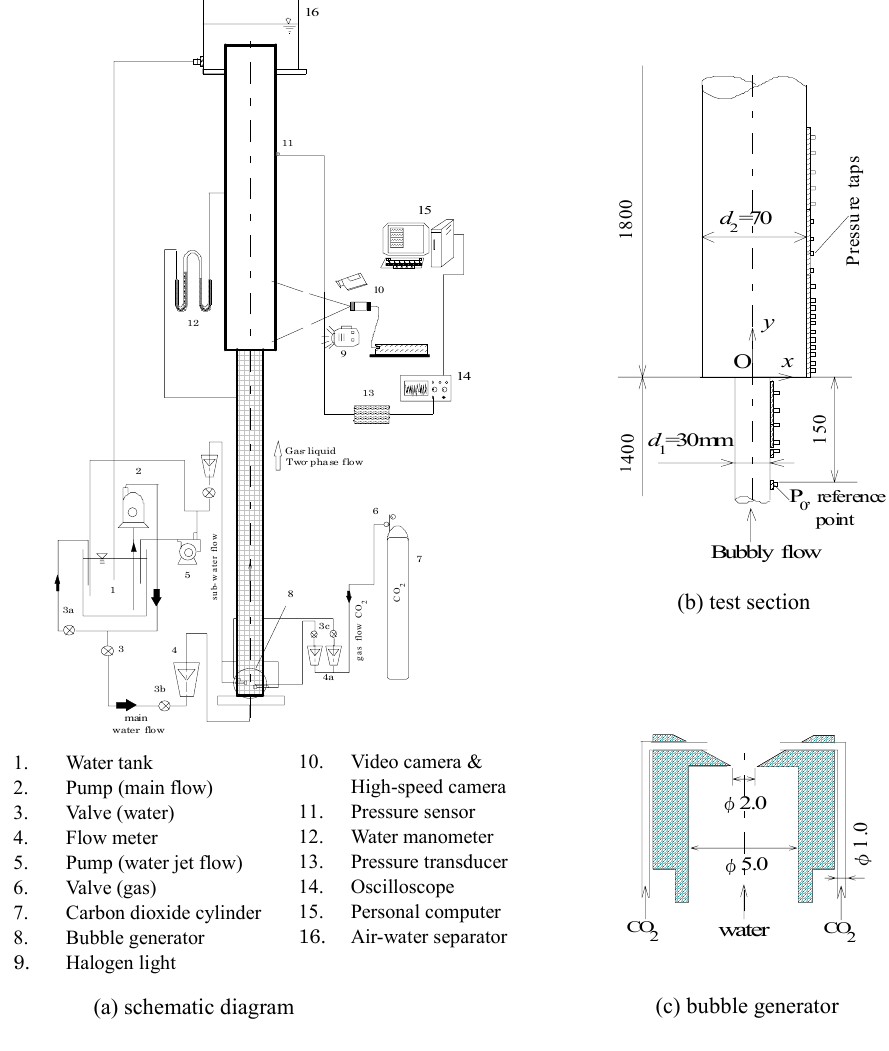
Fig.1 Experimental set-up and test section details